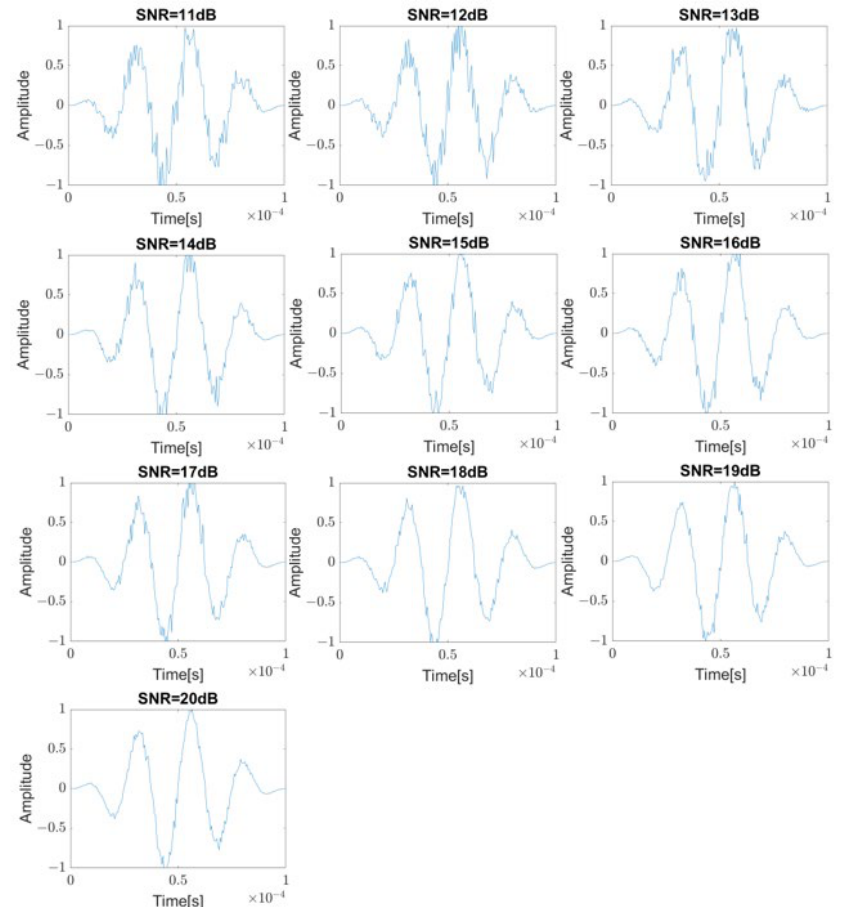
Figure 5. Excitation signal with center frequency of 40 kHz with SNR ranging from 11 dB to 20 dB.